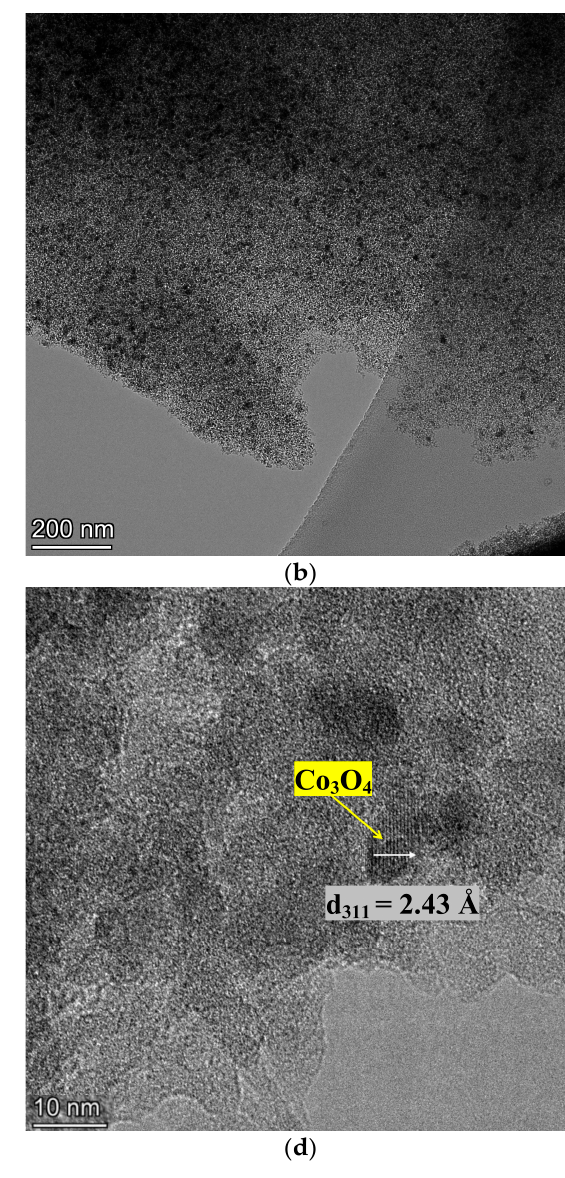
Figure 9. Low ( a ) and higher ( b – d ) magnification TEM images of Co-N-C/SiO 2 -R1 catalyst.